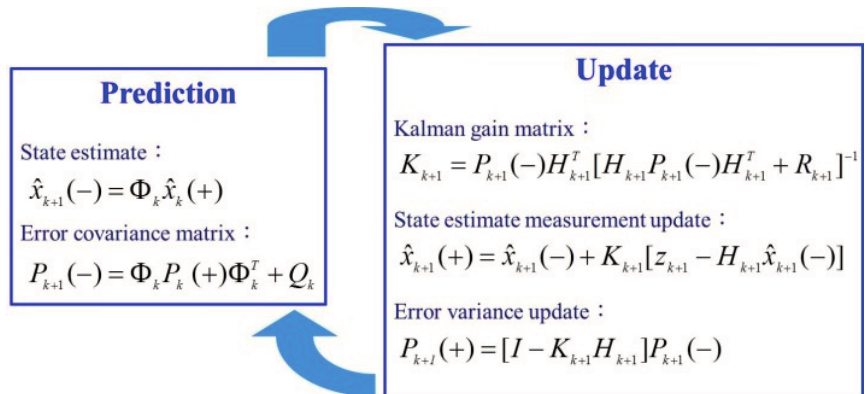
Figure 3. The equations of computational procedure for